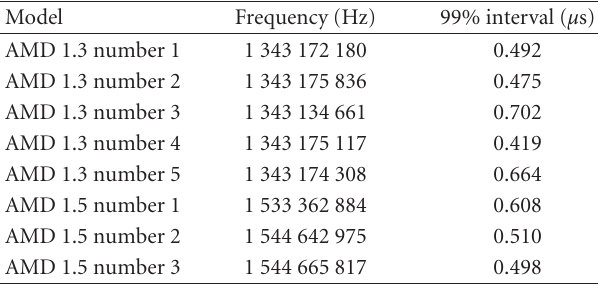
Table 6: Clock frequency for di ff erent computer models.